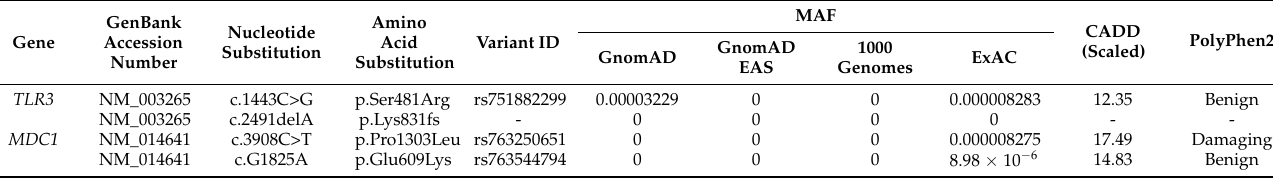
Table 3. Identified variants and their pathogenicity